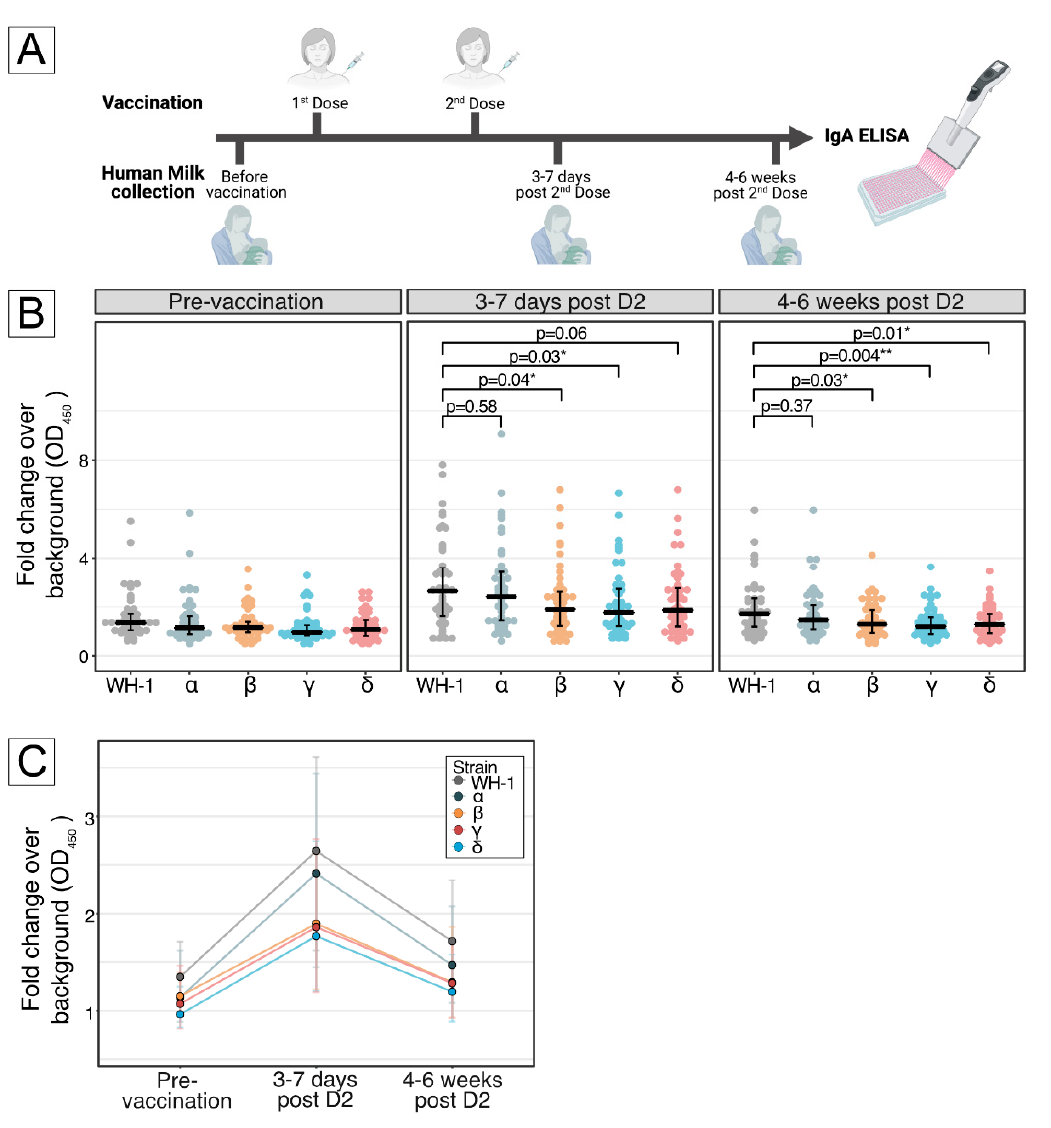
Figure 1. Detection of IgA binding to receptor binding domain of SARS-CoV-2 spike proteins encoded by the ancestral Wuhan-Hu-1 strain and selected major VOCs. ( A ) Schematic showing the collection times of human milk samples pre- and post-vaccination, as described in Materials and Methods. ( B ) Differential human milk IgA binding to receptor binding domain (RBD) of SARS-CoV-2 spike protein of the ancestral Wuhan-Hu-1 strain (WH-1), Alpha (B.1.1.7), Beta (B.1.351), Gamma (P.1) and Delta (B.1.617.2) variants of concern, after vaccination with BNT162b2 across 3 time points: pre-vaccination, 3–7 days post-D2 and 4–6 weeks post-D2. Each dot denotes an individual sample. Center line denotes the median, and error bars show Quartile 1 (bottom bar) and Quartile 3 (top bar). The p -values were calculated by using Dunn’s Many-to-One Rank Comparison Test and reported for VOC compared against WH-1, where p < 0.05 was considered significant; p < 0.05 is marked with *, and p < 0.01 is marked with **. At 3–7 days post-D2, reduction from WH-1 for Alpha = 8%, Beta = 28%, Gamma = 33% and Delta = 30%. At 4–6 weeks post-D2, reduction from WH-1 for Alpha = 14%, Beta = 25%, Gamma = 30% and Delta = 25%. ( C ) Kinetics of human milk IgA binding across 3 time points for ancestral Wuhan-Hu-1 strain (WH-1), Alpha (B.1.1.7), Beta (B.1.351), Gamma (P.1) and Delta (B.1.617.2) variants of concern. Each line represents 1 strain. Dots represent the median, and error bars represent interquartile range.